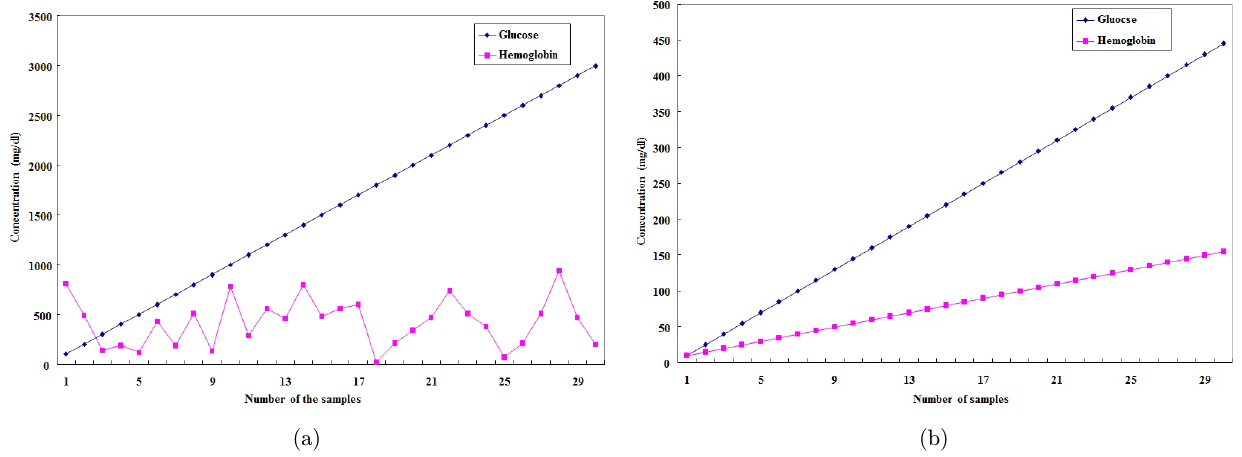
Fig. 2. Comparison between (a) uncorrelation between concentrations of glucose and hemoglobin and (b) chance correlation between concentrations of glucose and